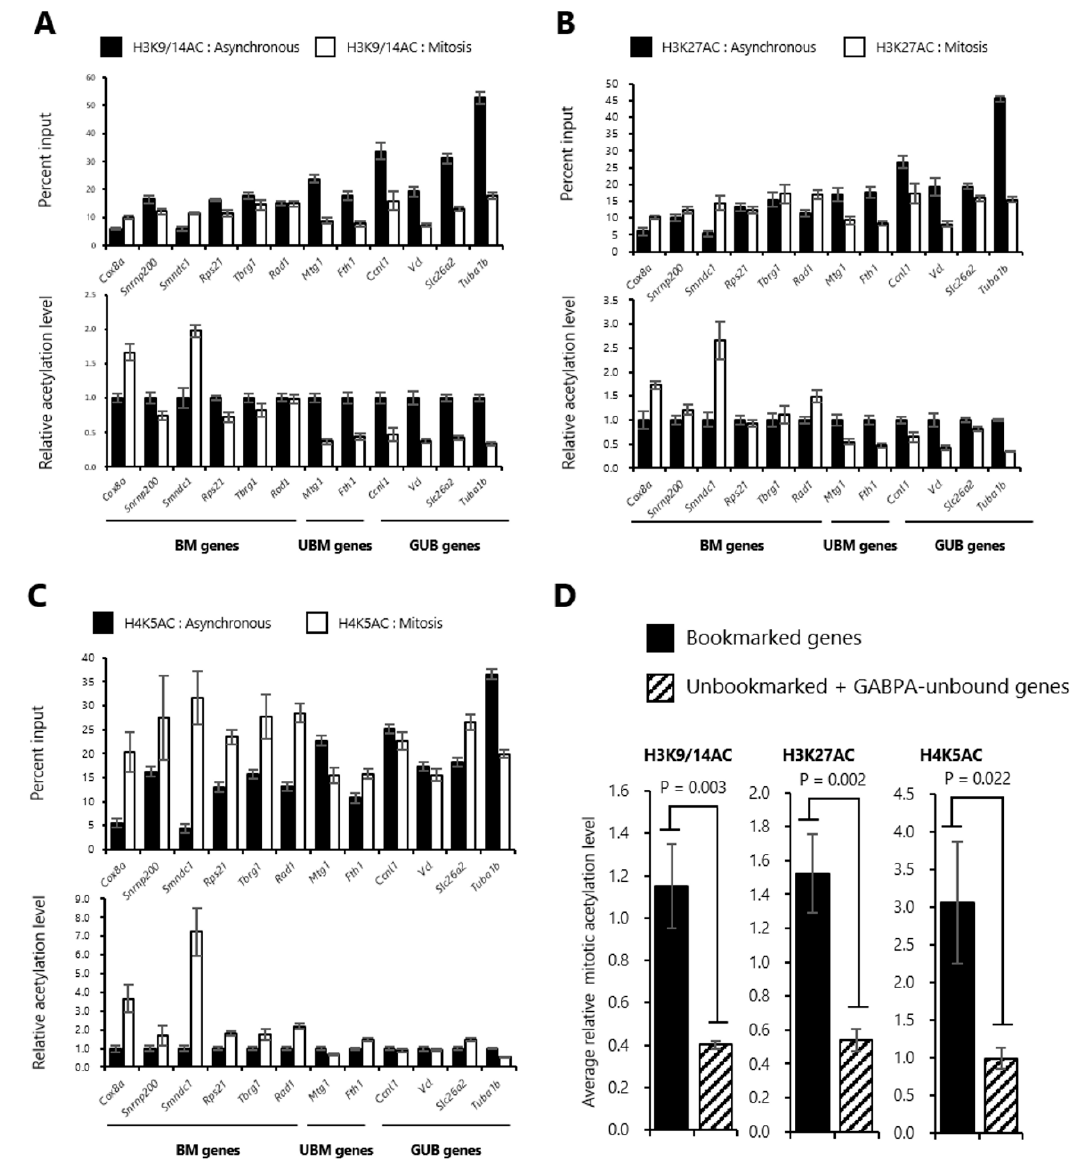
Figure 2. Histones at the sites bookmarked by GABPA are highly acetylated in mitosis. ( A–C ) The histone acetylation levels at upstream regions of the genes reactivated during the M/G1 transition in asynchronous and mitotic-arrested tsFT210 cells. Asynchronous and mitotic-arrested tsFT210 cells were subjected to chromatin immunoprecipitation assay using antibodies against H3K9/14AC ( A ), H3K27AC ( B ), and H4K5AC ( C ), followed by quantitative PCR using primer sets specific for the upstream regions of the bookmarked (BM), unbookmarked (UBM), and GABPA-unbound (GUB) genes. In each figure, the upper graph shows raw data plotted as percent input DNA and the lower graph shows the same data replotted relative to the asynchronous acetylation level. Error bars denote SEM ( n = 3). ( D ) Comparison of the average relative level of each mitotic histone acetylation at upstream regions of the bookmarked genes with those of unbookmarked and GABPA-unbound genes. Error bars denote SEM ( n = 3). Statistical significance was analyzed using a one-tailed Student’s t -test.